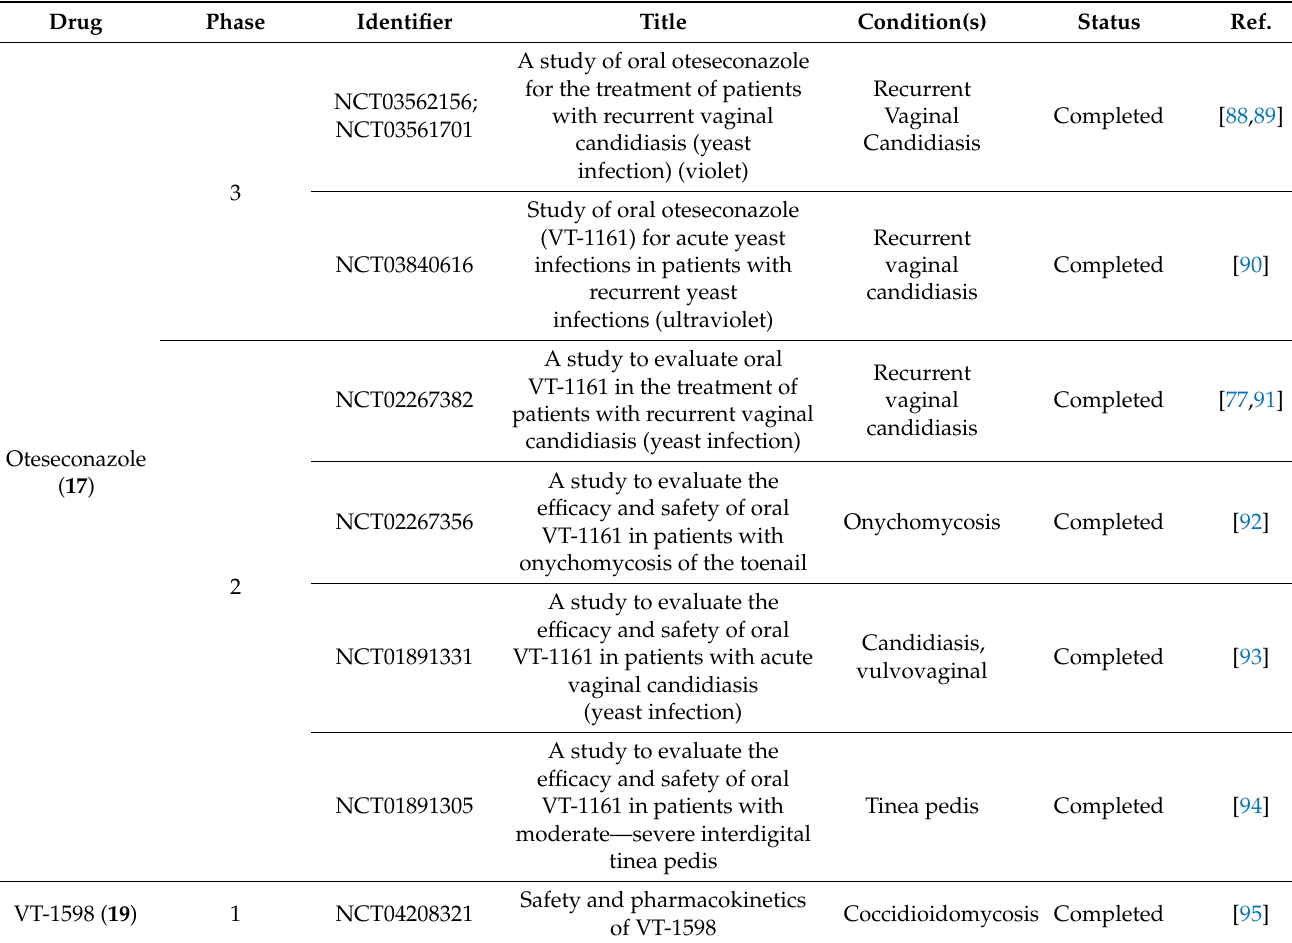
Table 6. Clinical trials for VT-1161 ( 17 ) and VT-1598 ( 19 ) (summarized).